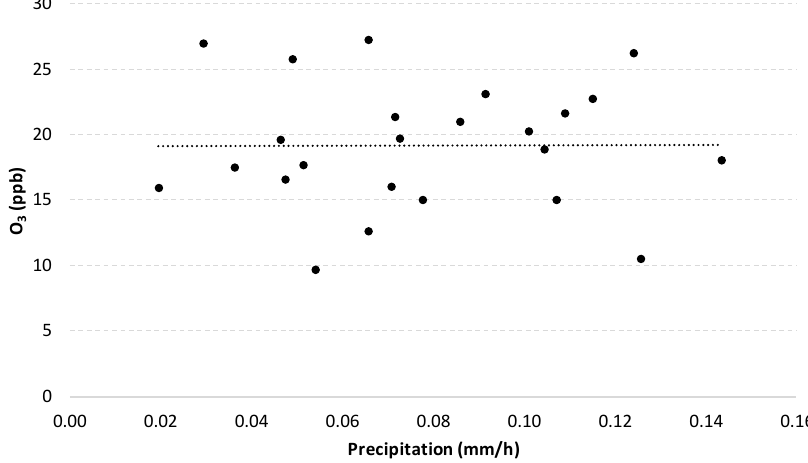
Figure 8. Ozone and precipitation average weekday school period.